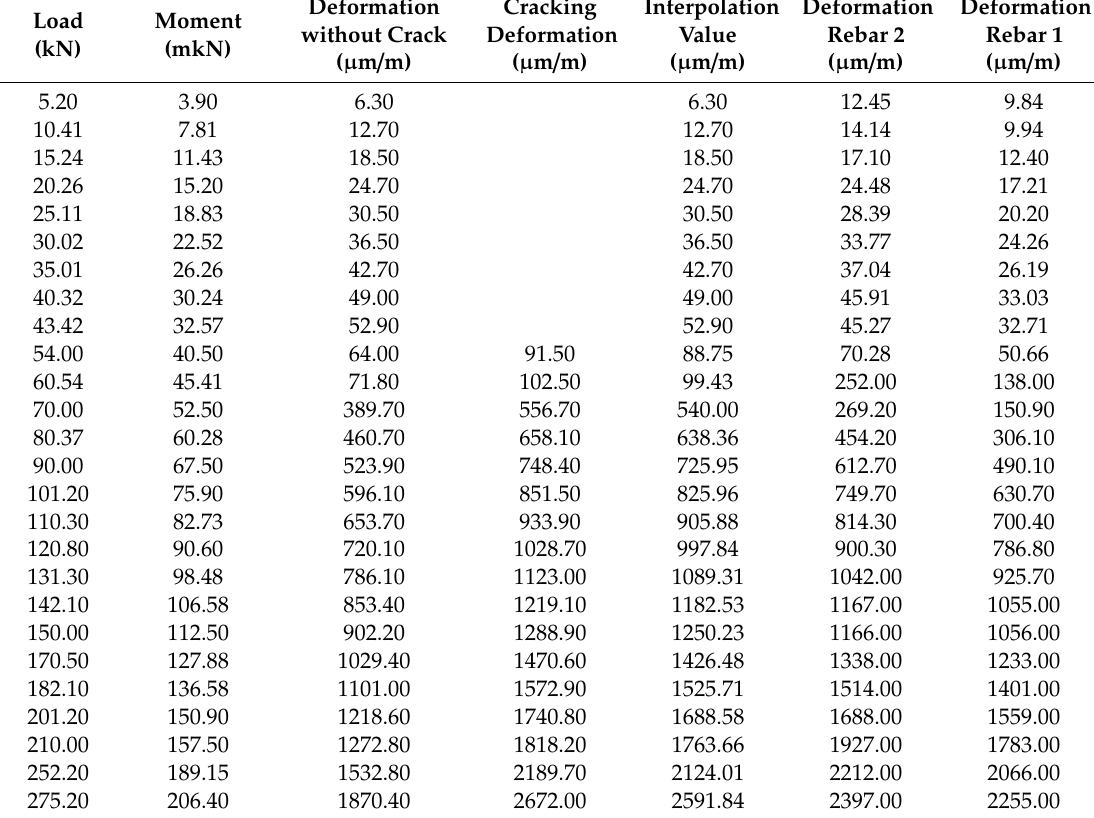
Table 11. Deformation of the rebars 1 and 2 for M fis = 40.5 mkN and f ct = 3.24 MPa with FAGUS.